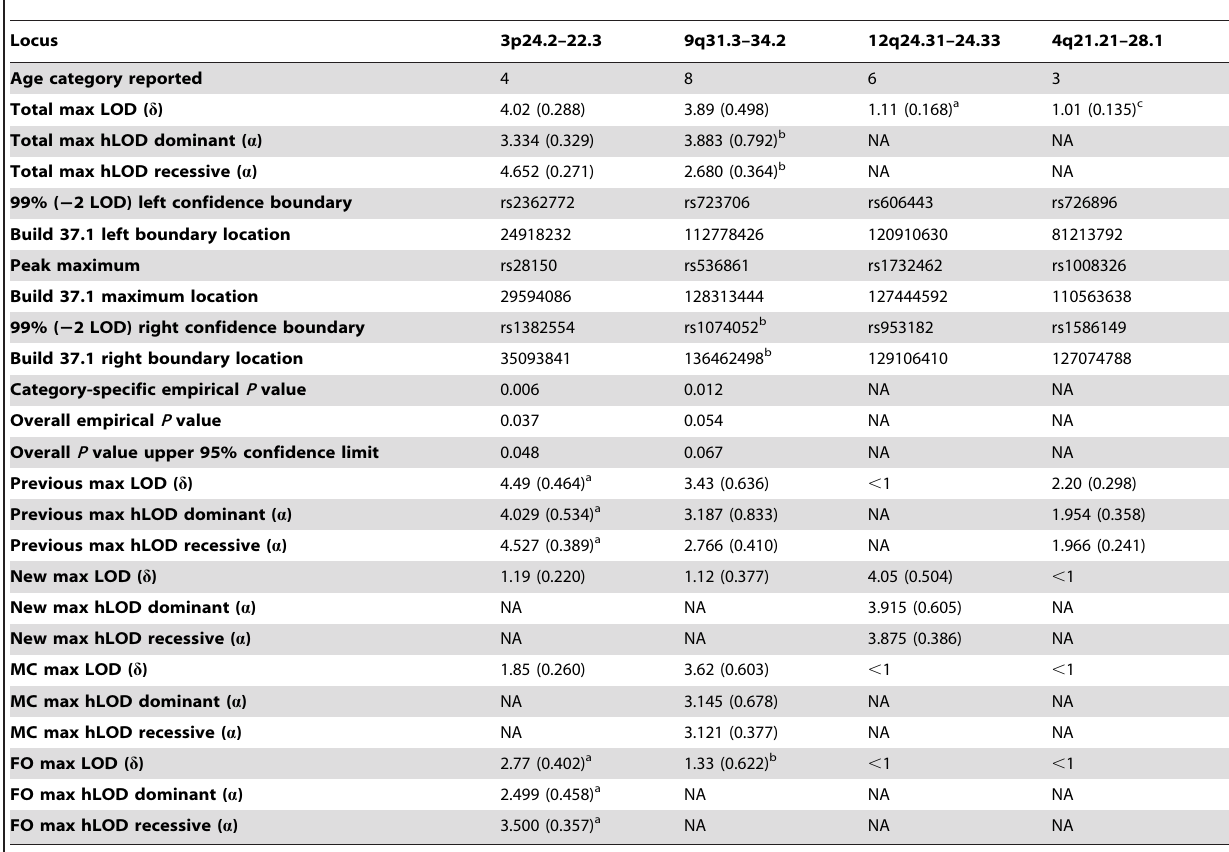
Table 2. Characteristics of chromosomes 3, 9, 12, and 4 linkage peaks.